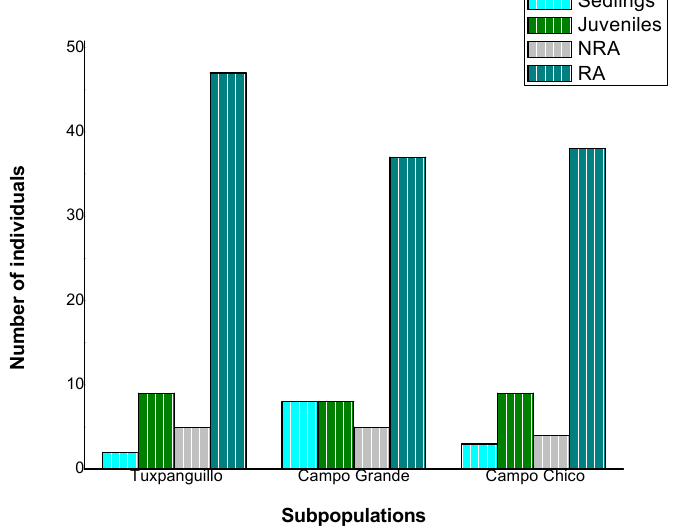
with 10 individuals, followed by Cerro de Acatepec and Las Cañadas with 8 and 7 indi- viduals, respectively. Regarding the number of seedlings, Cerro de Acatepec had 9 indi- viduals, followed by La Cañada with 5 and Cerro de Elotepec with 2 individuals. Finally,